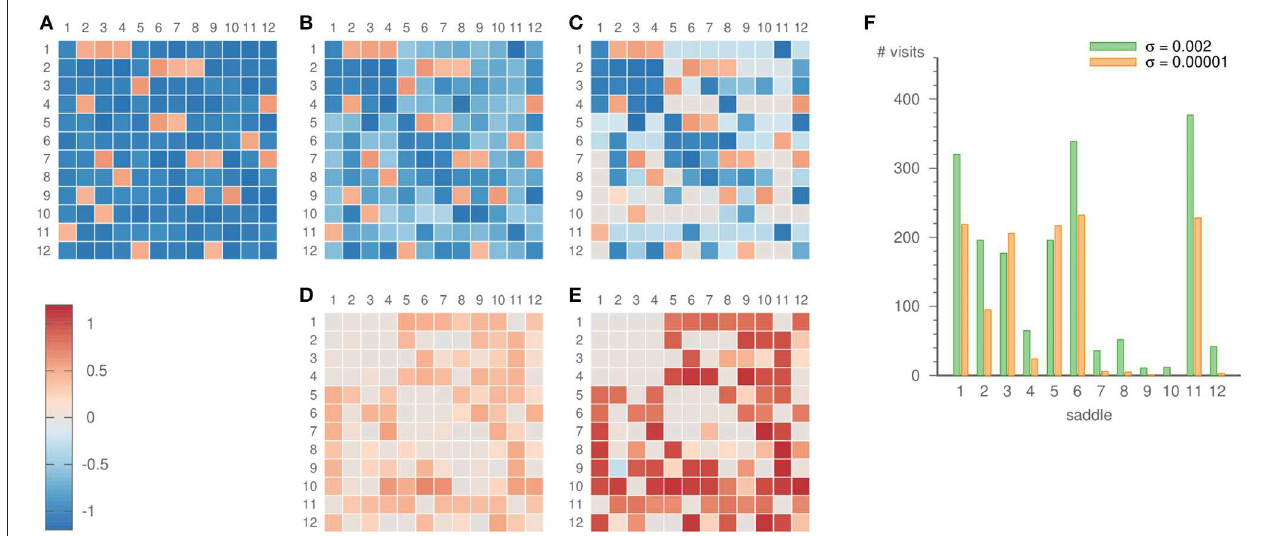
FIGURE 8 | Eigenvalues a i , j of the random heteroclinic network G . Panel (A) depicts the original values, (B) the values inferred with parameters ϑ σ 0.002, and (C) the values inferred with parameters ϑ = show the error of the inference, i.e., (D) the difference of panels (B,A) , (E) the difference of panels (C,A) . Panel (F) displays the number of times the dynamics visits each of the saddles for both noise